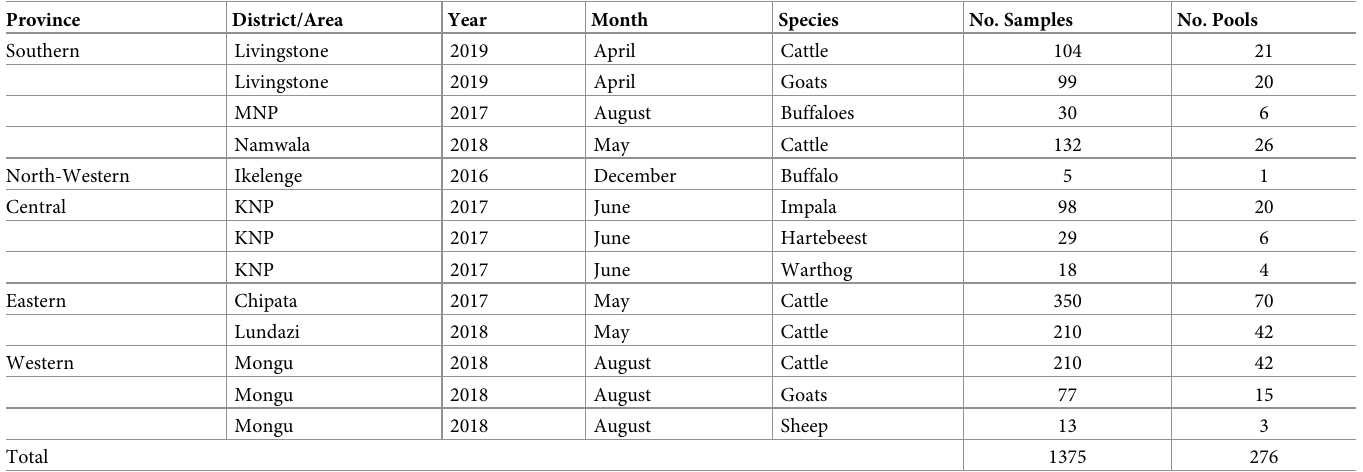
Table 1. Composition of sera from domestic and wild ruminants used for RVFV genome